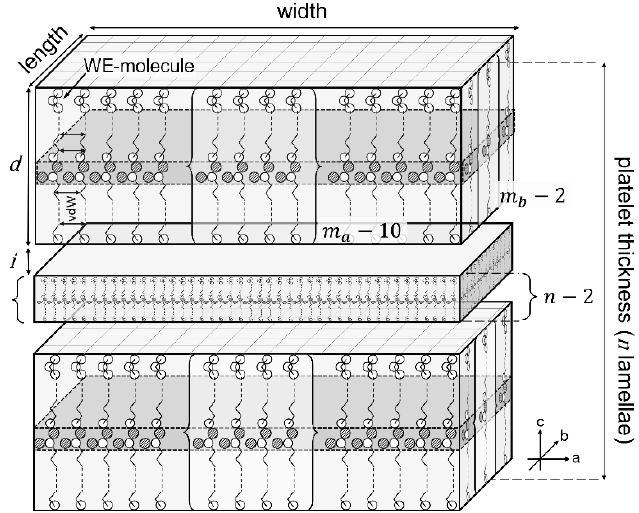
Figure 2. Schematic representation of WE crystal platelets built up of 𝑛 stacked single lamellae each being composed of 𝑚 𝑎 ∗ 𝑚 𝑏 individual WE molecules in monomolecular layers. The platelet thickness results from the height of the WE molecules ( d ), the number of lamellae ( n ) and the interlamellar distance 𝑖 .